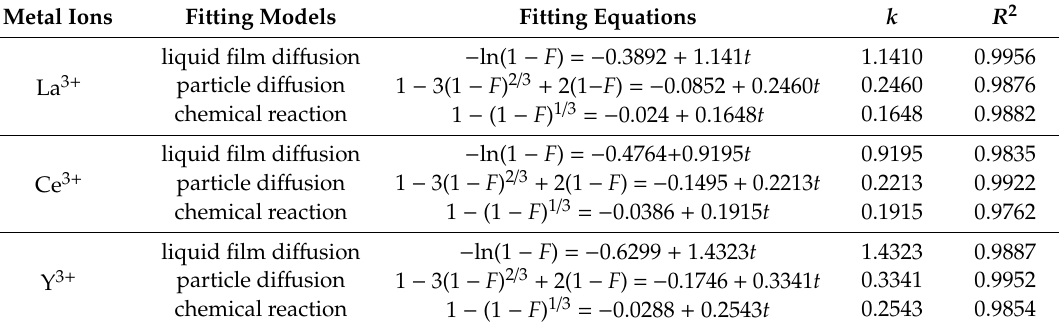
Table 1. The kinetic parameters of di ff erent kinetic models.